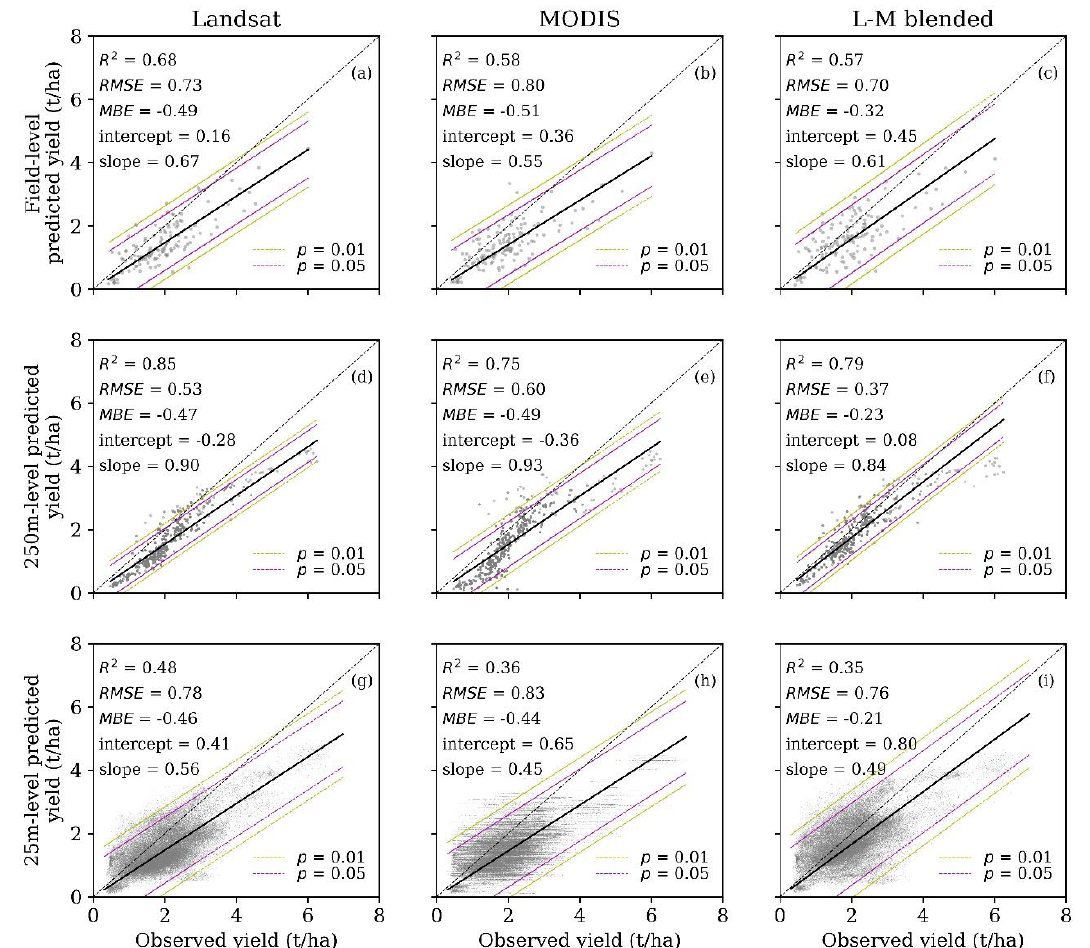
Figure 4. Validation of C-Crop-predicted yield pooled for wheat, barley, and canola using Landsat, MODIS, and L–M blended data where the complete Landsat time series are observed (the fraction of missing Landsat series = 0). From top to bottom, the first ( a – c ), second ( d – f ), and third ( g – i ) rows show the comparison between observed ( x -axis) and model-predicted yields ( y -axis) on the field scale ( n = 139), 250-m pixel level ( n = 2367), and 25-m pixel level (n = 113,329), respectively, where n is the sample size. From left to right, the first ( a , d , g ), second ( b , e , h ), and third ( c , f , i ) columns delineate the validation using Landsat, MODIS, and L–M blended data, respectively. The solid black line is the line of best fit, the purple and the yellow lines represent the upper and lower bounds of the prediction confidence intervals (i.e., p = 0.01 and p = 0.05), and the black dashed line is the 1:1 line.